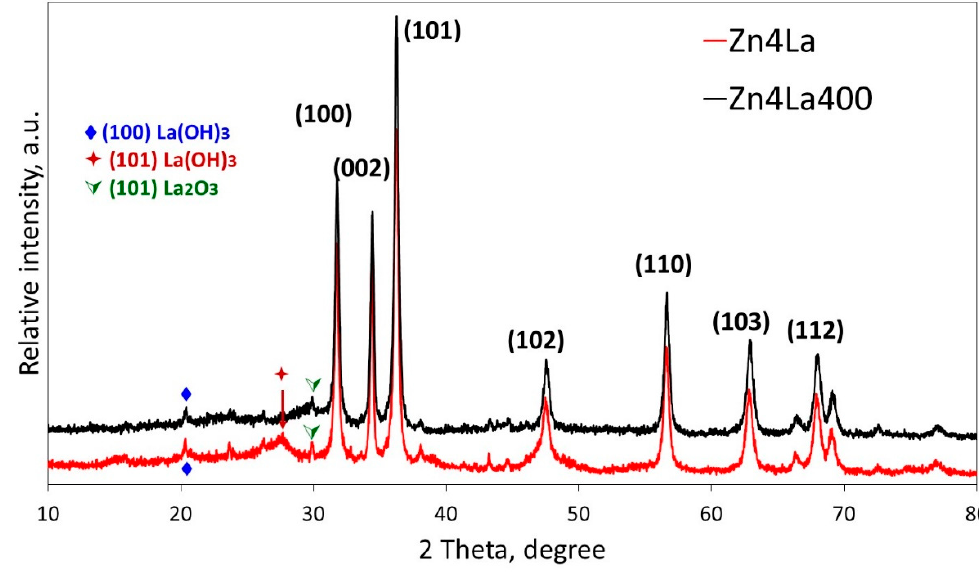
Figure 2. X-ray di ff raction (XRD) patterns of samples Zn4La and Zn4La400.